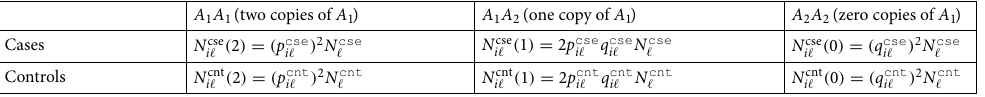
Table 10. Genotype counts for cases and controls for SNP i in study ℓ . Using the above formulas, we can reconstruct the genotype counts for cases and controls for each of the three possible